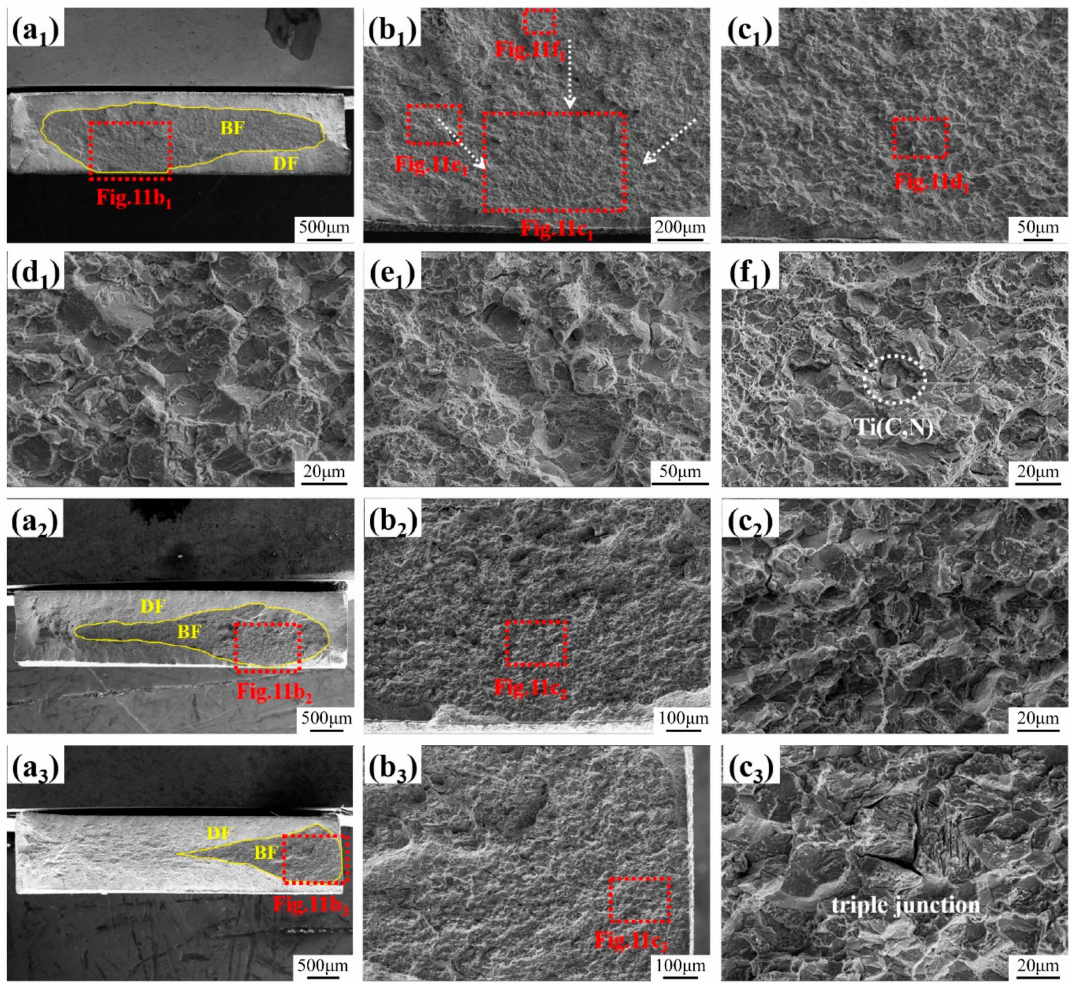
Figure 11. SEM images of fracture surface of specimens with 24 h pre-charging and a strain rate of 1 × 10 − 6 s − 1 . The yellow solid lines indicate the boundaries between the brittle fractured region (BF) and the ductile fractured region (DF). The white dashed arrows in ( b 1 ) indicate the possible direction of hydrogen di ff usion while the specimen was being stretched. The white dotted circle in ( f 1 ) marks the inclusion Ti(C, N). The numbers 1 , 2 , and 3 represent three parallel samples,